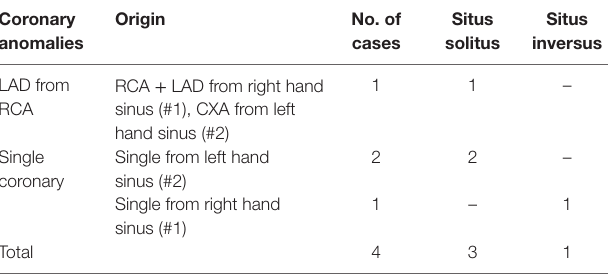
TaBle 10 | corrected Tga: coronary